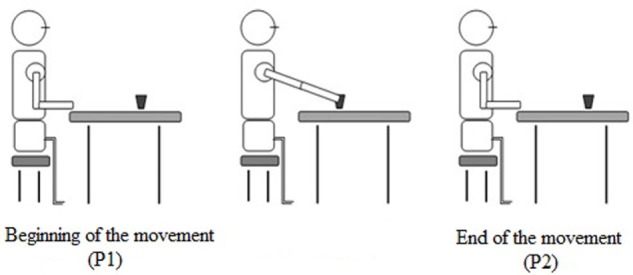
Reaching movement.